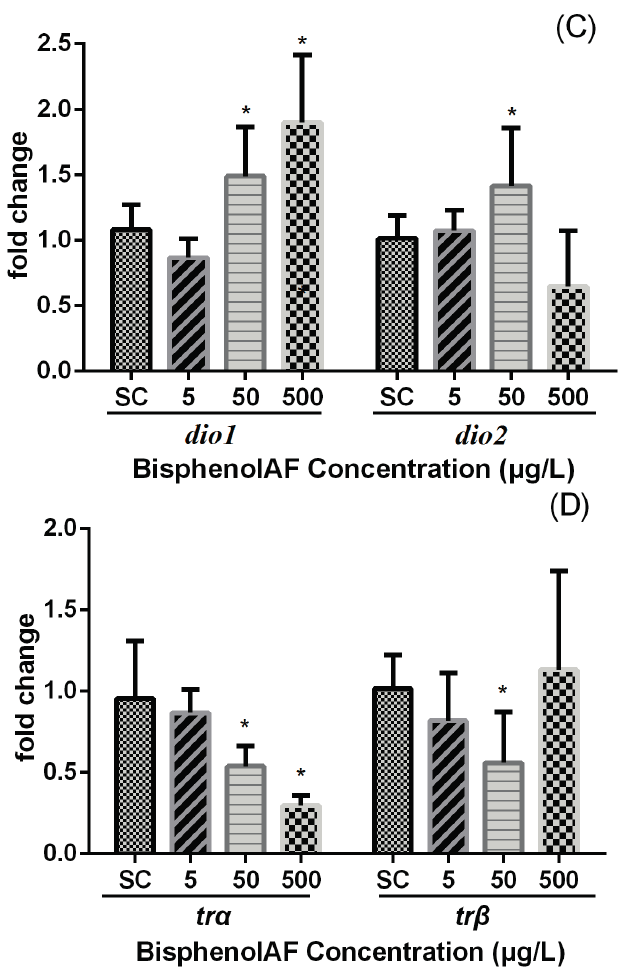
Figure 3. Relative mRNA expression levels of ( A ) tsh β and slc5a5, ( B ) tg and ttr, ( C ) dio1 and dio2, ( D ) tr α and tr β in zebrafish larvae exposed to different concentrations of BPAF at 168 hpf (SC: 0.1% DMSO, 5, 50 and 500 μ g/L, respectively). Fold change (Y axis) represents the expression of the target gene mRNA relative to that of the whole-body control group (equals 1 by definition). Data expressed as the means ± standard error of mean (SEM) ( n = 6). Asterisks ( * ) represents p < 0.05 for significant difference. The expression of dio1 significantly increased at 50 and 500 μ g/L BPAF exposure in